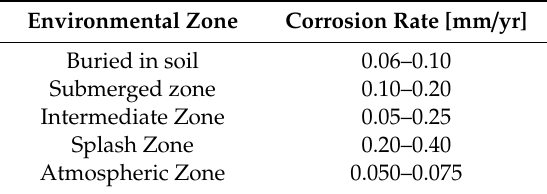
Table 3. Standard corrosion rates for different sections. Environmental Zone